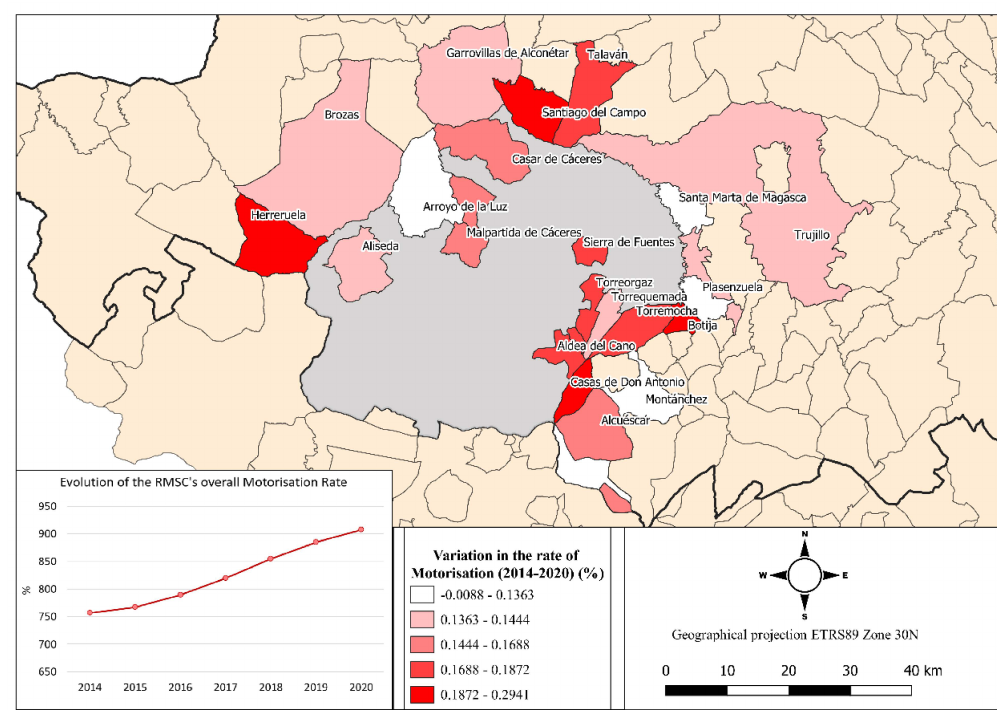
Figure 4. General motorisation of the RMSC (2014 – 2020).